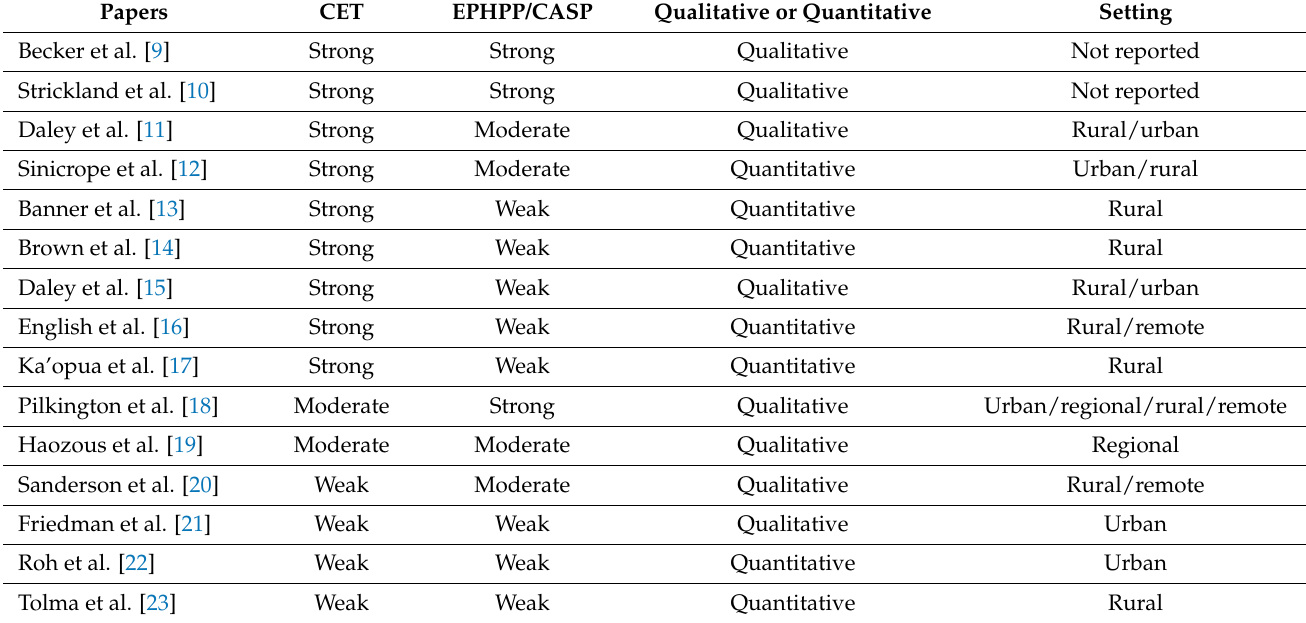
Table 1. Results of the community engagement tool (CET), typical tool scores, and setting by paper.